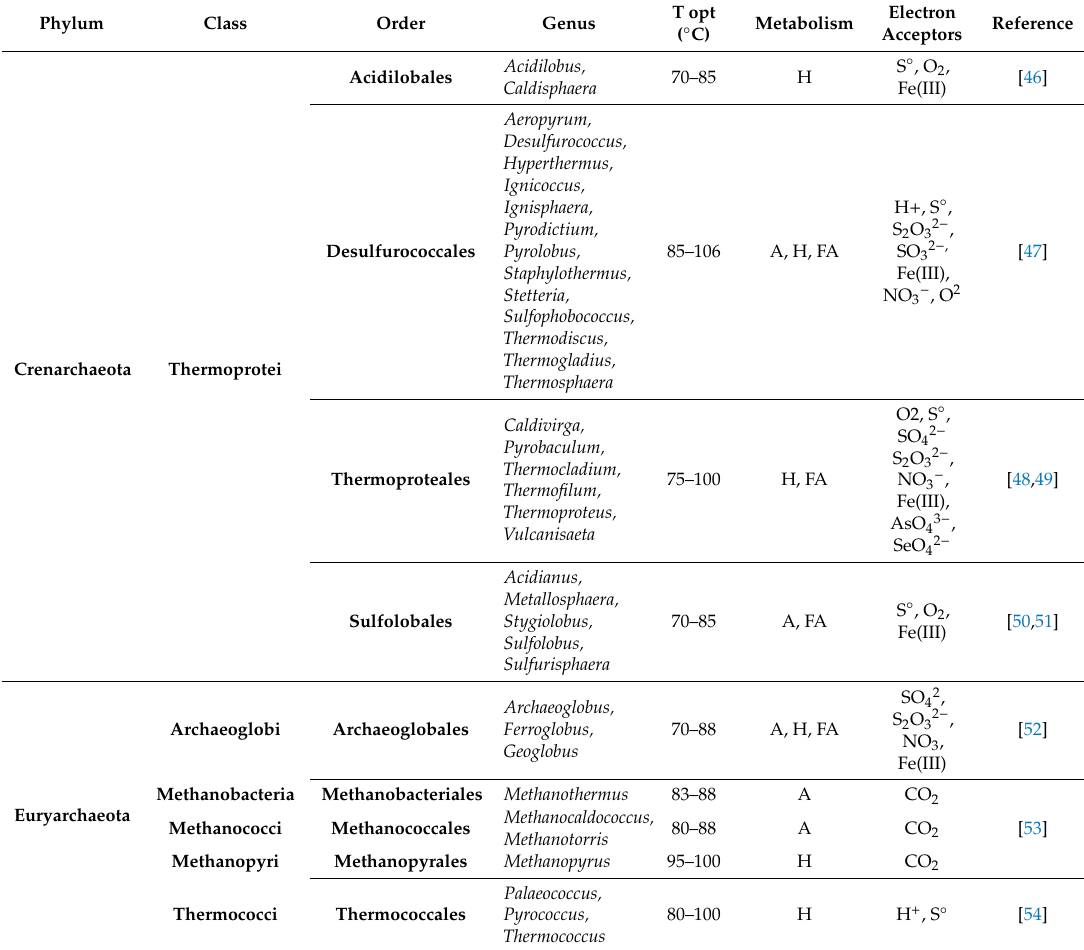
Table1. Somecharacteristicsofarchaeathatgrowabove70 ◦ C.Thegenera, optimalgrowthtemperatures, type of metabolism (A: autotrophic, H: heterotrophic, FA facultatively autotrophic), and electron acceptors are provided for each listed